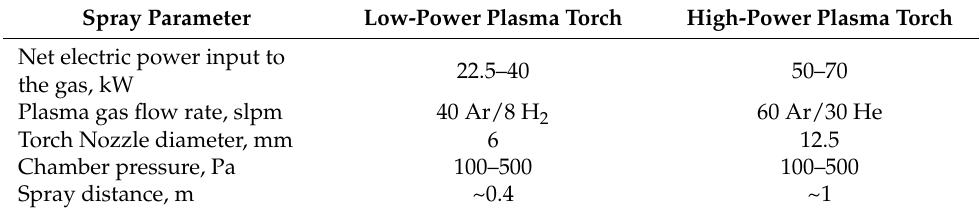
Table 2. Operating parameters for the Ar–H 2 and Ar–He plasma jet. Spray Parameter